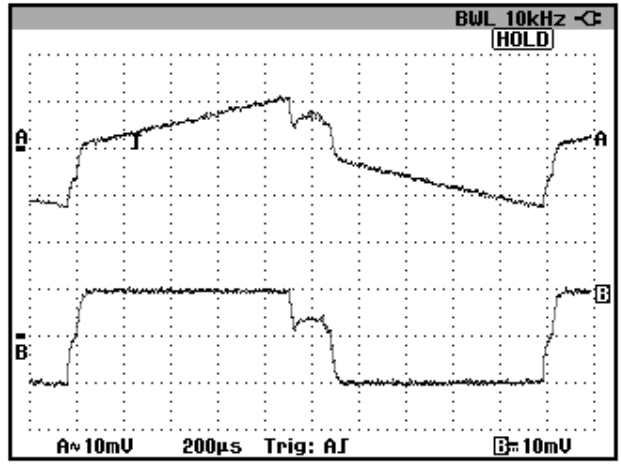
Figure 25. Experimental capacitor voltage and current with one charge-boost-discharge